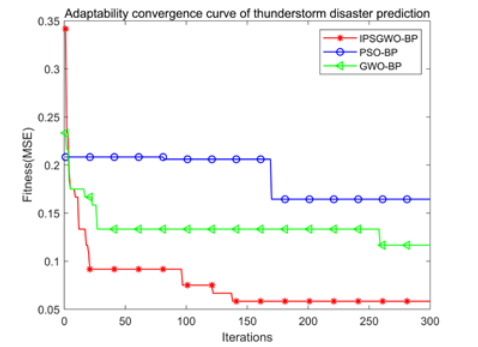
Fig. 3. Comparison of convergence curves of thunderstorm disaster